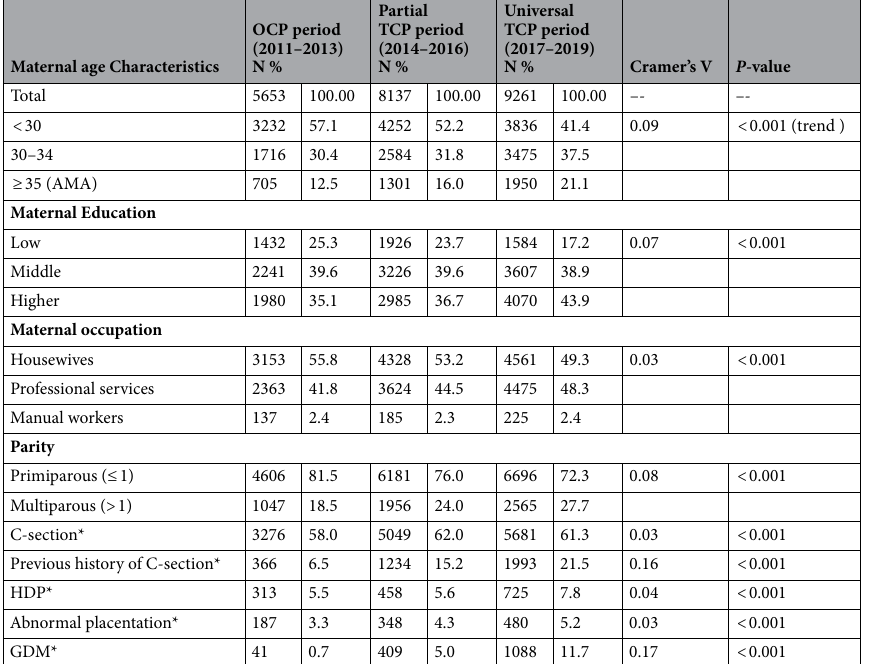
Table 1. Changes in maternal characteristics from OCP (One-child policy) period to universal TCP (Two-child policy) period. * = Frequency and percentage of variables with only ‘Yes’ value presented , AMA abruption), GDM (Gestational diabetes mellitus), p-values were calculated using chi-square